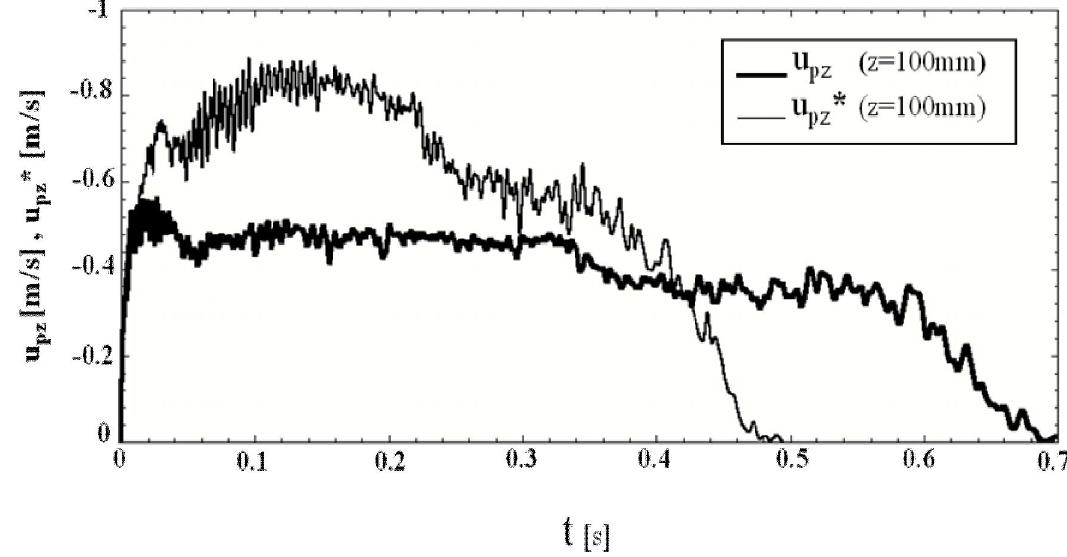
Figure 7. Evolution of calculated vertical granular velocities at the center of slit, u presence of air and, u * in a vacuum. The granular velocity is a calculated value averaged pz in an air computational